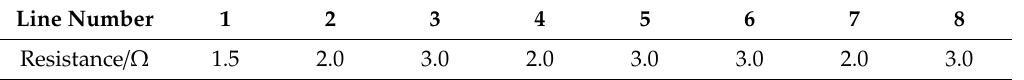
Table A4. The monopolar line resistance of the 6-terminal VSC-MTDC system.